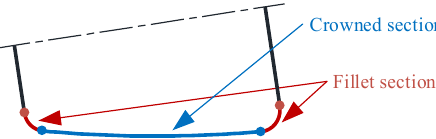
Figure 12. Crowned section and fillet section of tapered roller.